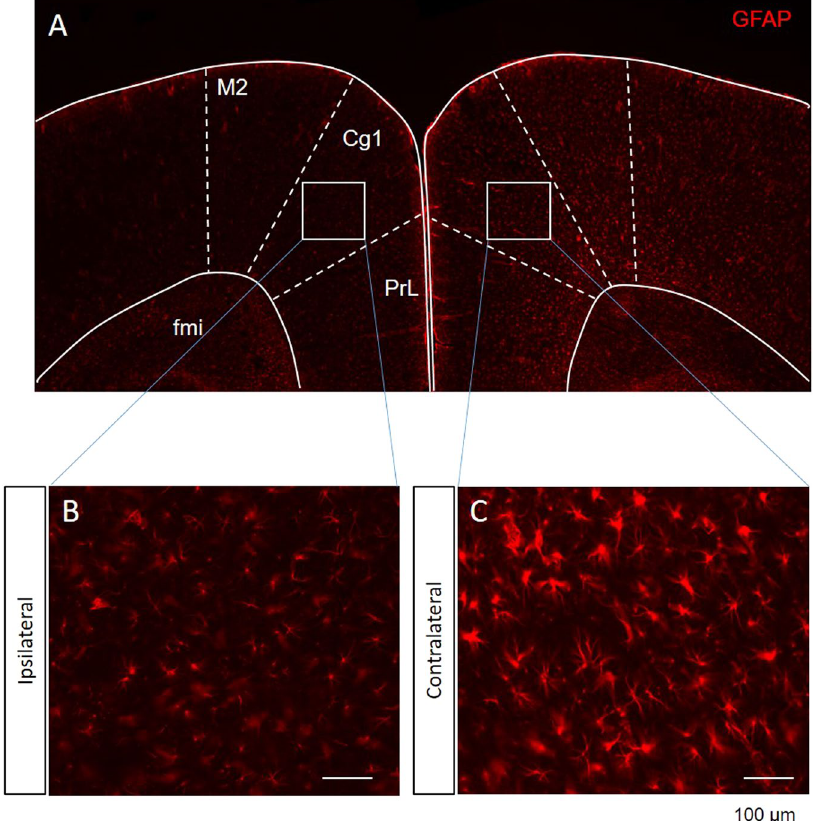
Figure 7. The morphological appearance of astrocytes in the ACC of NP rats. ( A ) Comparison of the different GFAP expression levels in the ipsilateral and contralateral sides of the ACC region. ( B ) Ipsilateral and ( C ) contralateral sides of the ACC in NP rats. (Scale bar, 100 μ m; M2: secondary motor cortex, Cg1: cingulate cortex area 1, PrL: prelimbic cortex, fmi: forceps minor corpus